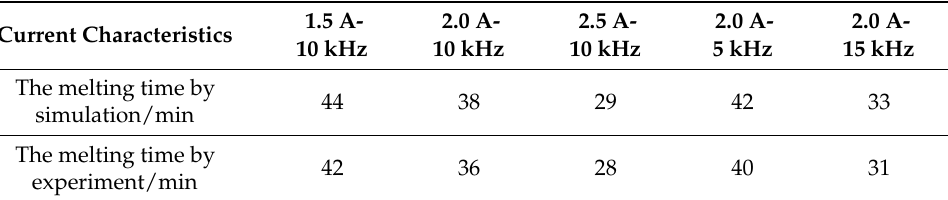
Table 6. The melting time under different excitation current.